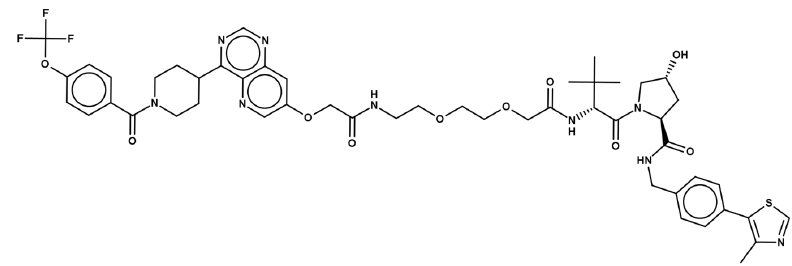
Figure 1. Chemical structure of PROTAC ‐ 1.